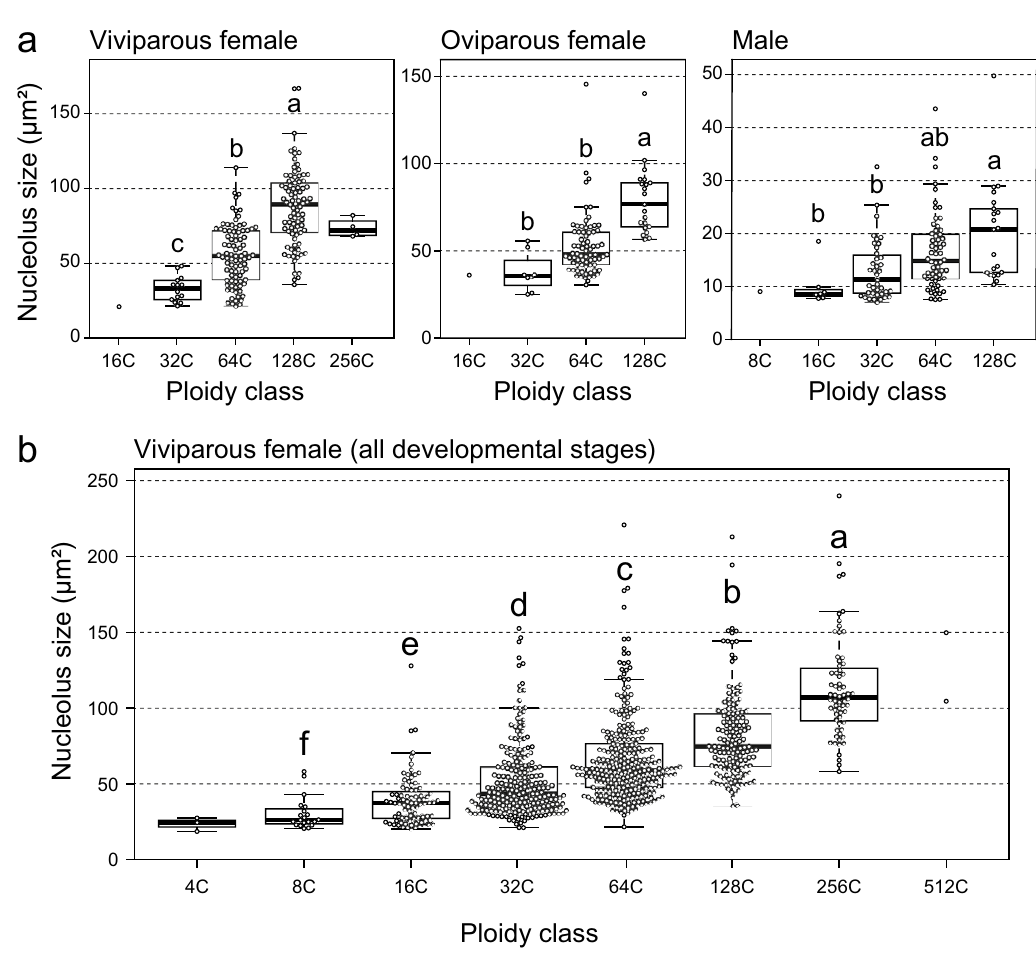
Figure 6. The relationship between the size of nucleolus and ploidy levels of aphid bacteriocytes. In the boxplots, central bold lines represent the medians, boxes comprise the 25–75 percentiles and whiskers denote the range. ( a ) The size of nucleolus was significantly different among ploidy class in all aphid morphs (LM with type II test; p < 0.001 each). Different letters indicate significant differences (Tukey’s test, p < 0.05). Note that 16C/256C, 16C, and 8C bacteriocytes in viviparous, oviparous females and males, respectively, were excluded from these analyses due to the small sample size. ( b ) Nucleolus size was significantly different among ploidy class in viviparous females (LMM with type II test; p < 0.001). Different letters indicate significant differences (Tukey’s test, p < 0.05). Note that 4C and 512C were excluded from this analysis due to the small